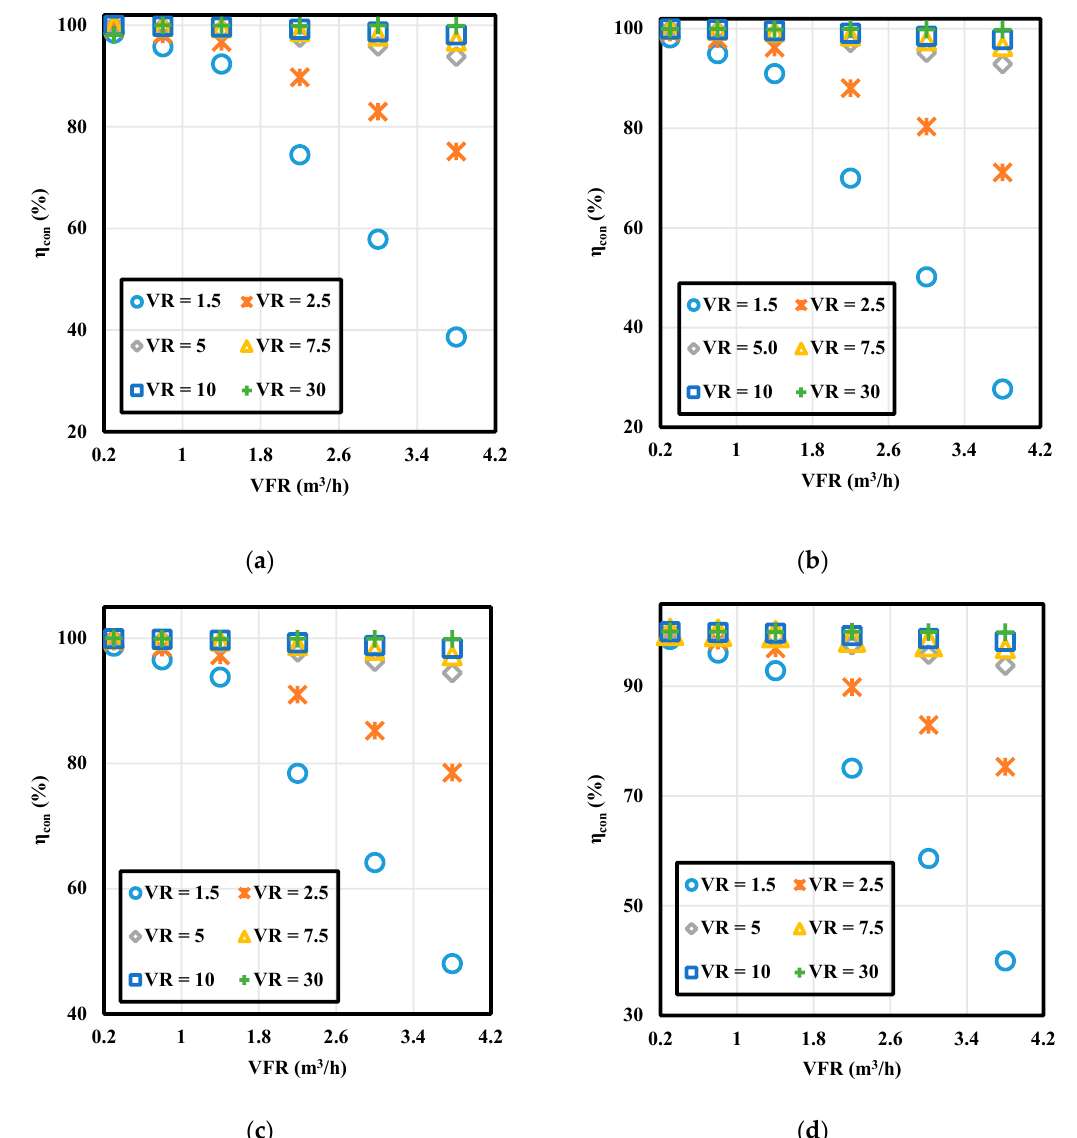
Figure 7. Contracted energy efficiencies for various volume ratios (VR) and volumetric flow rates (VFR, in m 3 / hr), for initial PCM - HTF temperatures of: ( a ) 403–460 K, ( b ) 418–460 K, ( c ) 403–473 K, ( d ) 418–473 K.